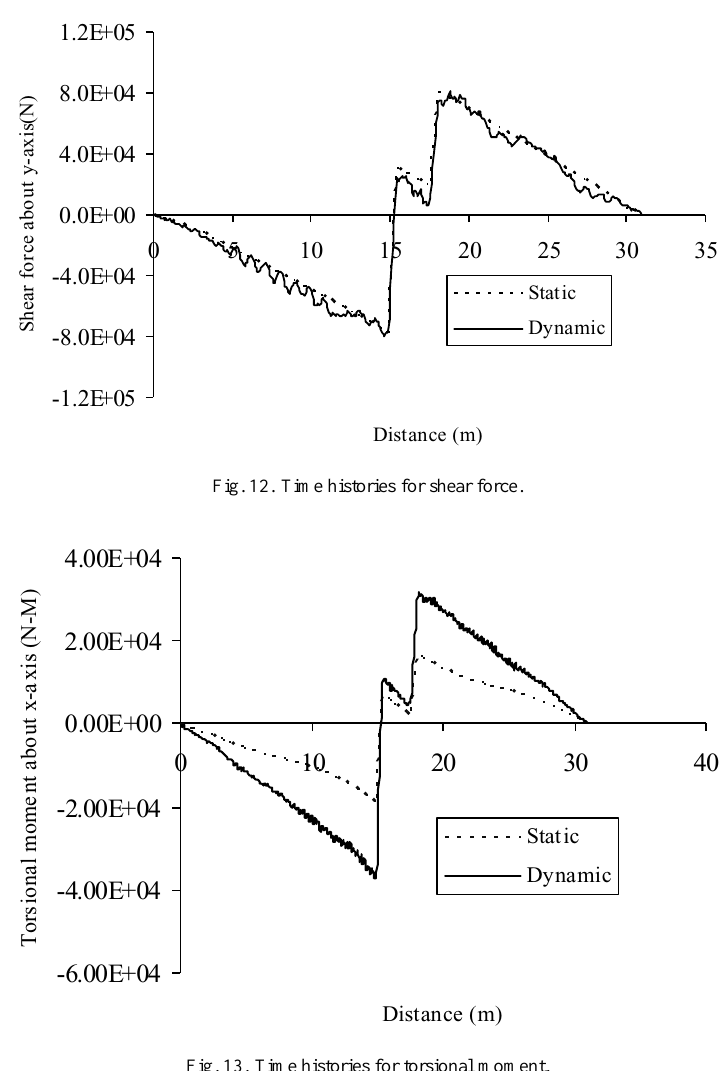
Fig. 13. Time histories for torsional